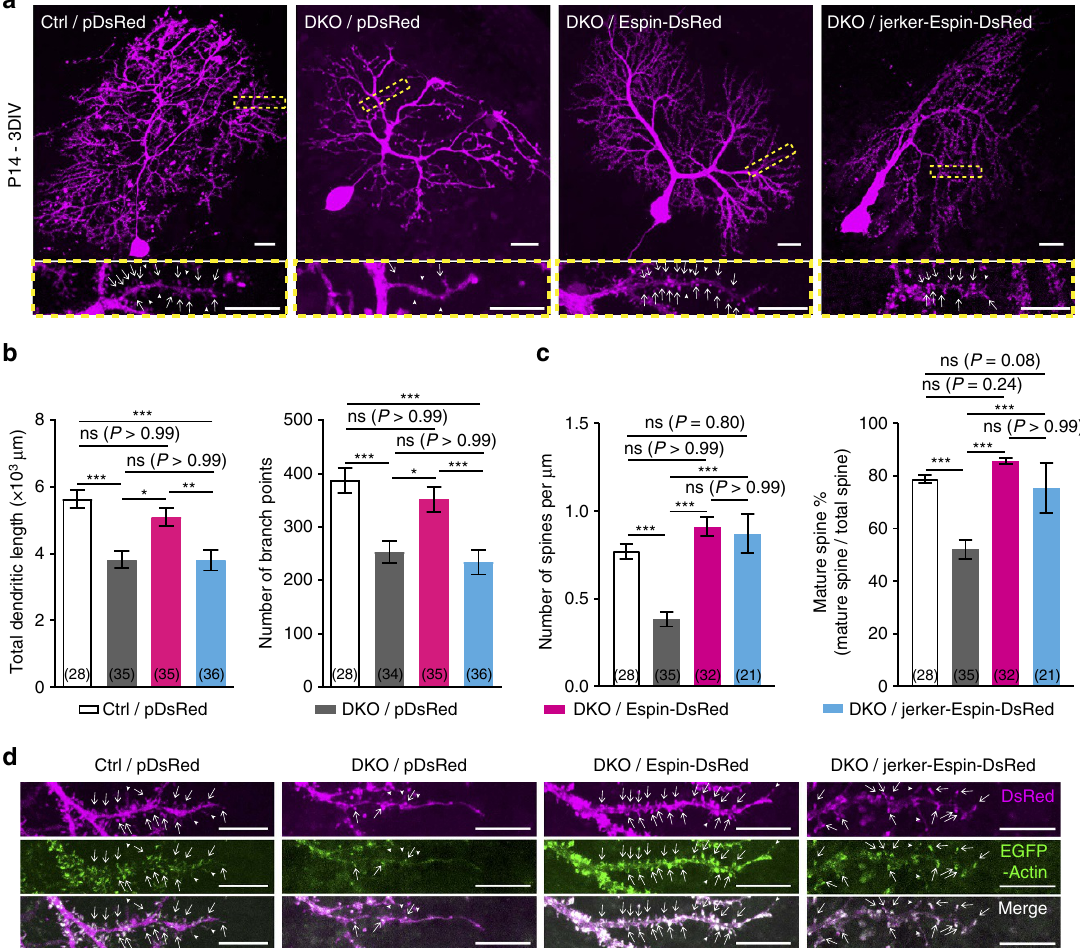
Figure 8 | Overexpression of Espin rescues the dendritic defects in the PCs of the DKO mutants ex vivo . ( a ) Representative PCs from P14 cerebellum slice cultures of the DKO mutants transfected with pDsRed or Espin-DsRed or jerker-Espin-DsRed and collected at 3 days in vitro (DIV). PCs from P14 control mice transfected with pDsRed served as the controls. Zoom-in images of yellow boxed regions show the dendritic spines of the respective PCs. Note that the dendritic trees of the mutant PCs transfected with Espin-DsRed were more extensive and had more mature spines. Scale bars, 20 m m; 10 m m (zoom-in). ( b ) Bar graphs showing the total dendritic length (left) and the branching number (right) of transfected PCs. The dendrite elongation and branching of the mutant PCs restored to the controls’ level after transfection of Espin-DsRed. ( c ) Bar graphs showing the density of dendritic spines (left) and the percentage of mature spines (right). Spinogenesis and spine maturation of the mutant PCs significantly increased after transfection of Espin-DsRed or jerker-Espin-DsRed. Brackets show the number of transfected PCs analysed. N ¼ 4–9 mice. Kruskal–Wallis test; ns, not significant; * P o 0.05, ** P o 0.01 and *** P o 0.001. ( d ) Distal dendrites of PCs from the controls or the mutants co-transfected with EGFP-Actin and pDsRed or Espin-DsRed or jerker-Espin- DsRed. White arrows point to the mature spines while arrowheads point to the immature spines. Both normal Espin and jerker-Espin were highly colocalized with F-actin in the dendritic spines of the transfected PCs. Scale bars, 10 m